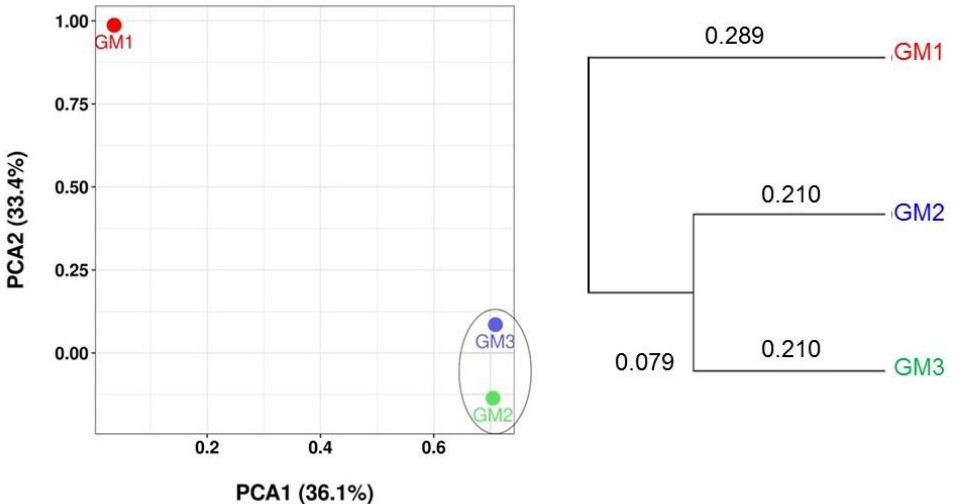
Figure 8. PCA-based grouping ( left ) and hierarchical clustering dendrogram ( right ) of OTU-affili- ated species in GM1, GM2, and GM3 speleothems. PCA and dendrogram for genera, families, or- ders, classes, and phyla are shown in supplementary Figures S6 – S10.